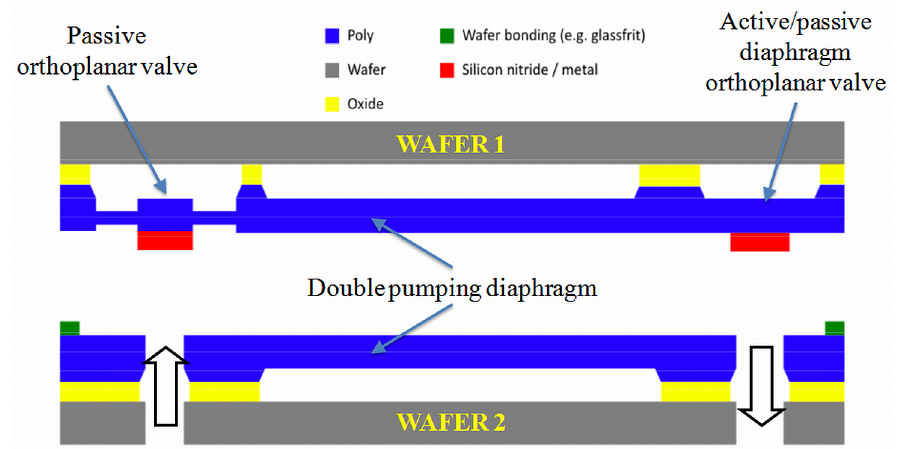
Figure 1. A schematic view of the micropump proposed in Reference [12] and adopted in the present paper with the addition of a piezoelectric actuation.